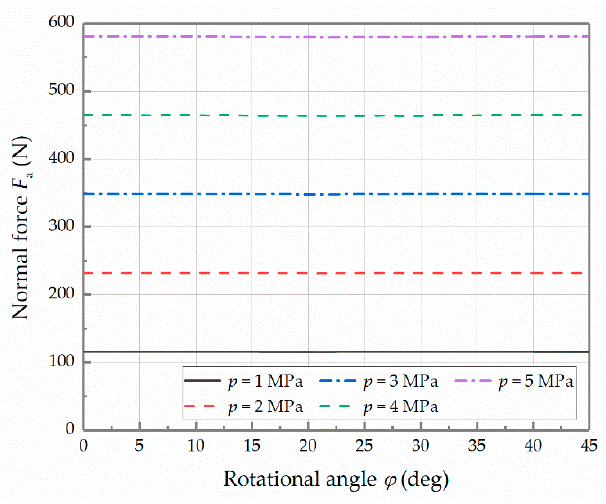
Figure 12. Curves of the normal force F a at different pressures.